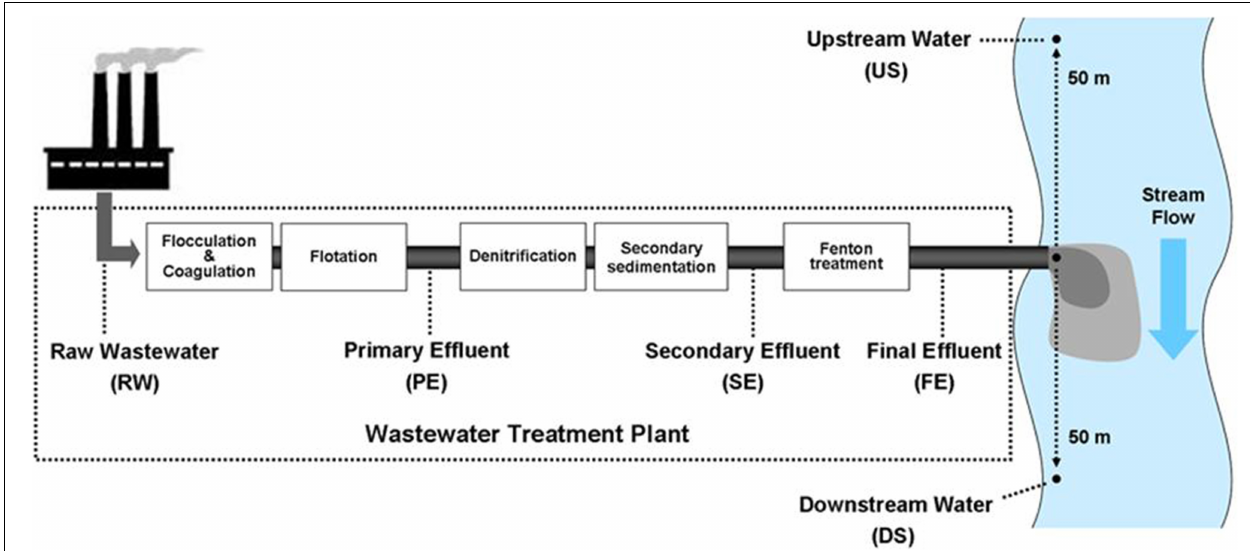
FIGURE 1 | Sampling points in a wastewater treatment plant and the adjacent stream. RW, raw wastewater; PE, primary effluents; SE, secondary effluents; FE, final effluents; US, upstream water; DS, downstream